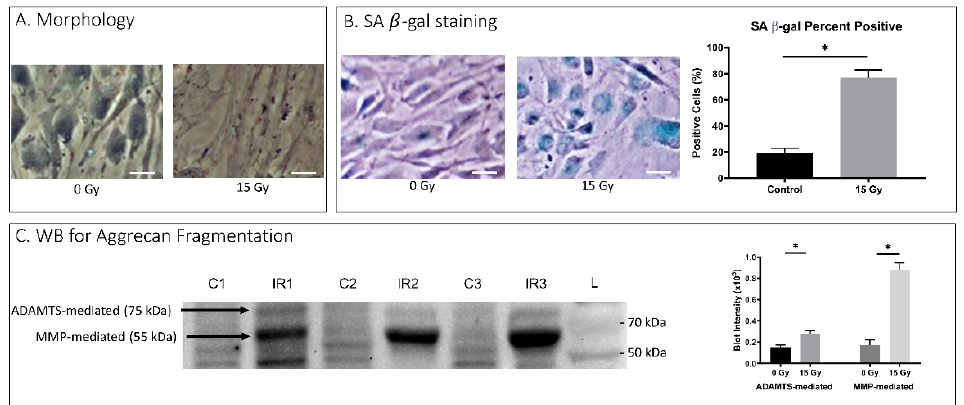
Figure A1. Senescence and matrix breakdown in Human AF Cells. Depicts results from in vitro human AF cell ionizing radiation experimentation. ( A ) Morphology depicts changes in cellular appearance after the administration of 15 Gy ionizing radiation visible on light microscopy. ( B ) Senescence-associated β -galactosidase assay with culture morphology in light microscopy (left) and proportion of assay-positive cells indicating senescence with 15 Gy ionizing radiation dose. ( C ) WB for Aggrecan Fragmentation depicts 3 control and 3 ionizing radiation western blot results for aggrecan fragmentation mediated by ADAMTS (75 kDA) or MMP (55 kDA) (left). Quantification of band intensities from western blot ADAMTS and MMP fragmentation are depicted (right) with 15 Gy dose of ionizing radiation and 0 Gy dose control. On microscopic images, the white bar for scale measures 20 µ m. * p ≤